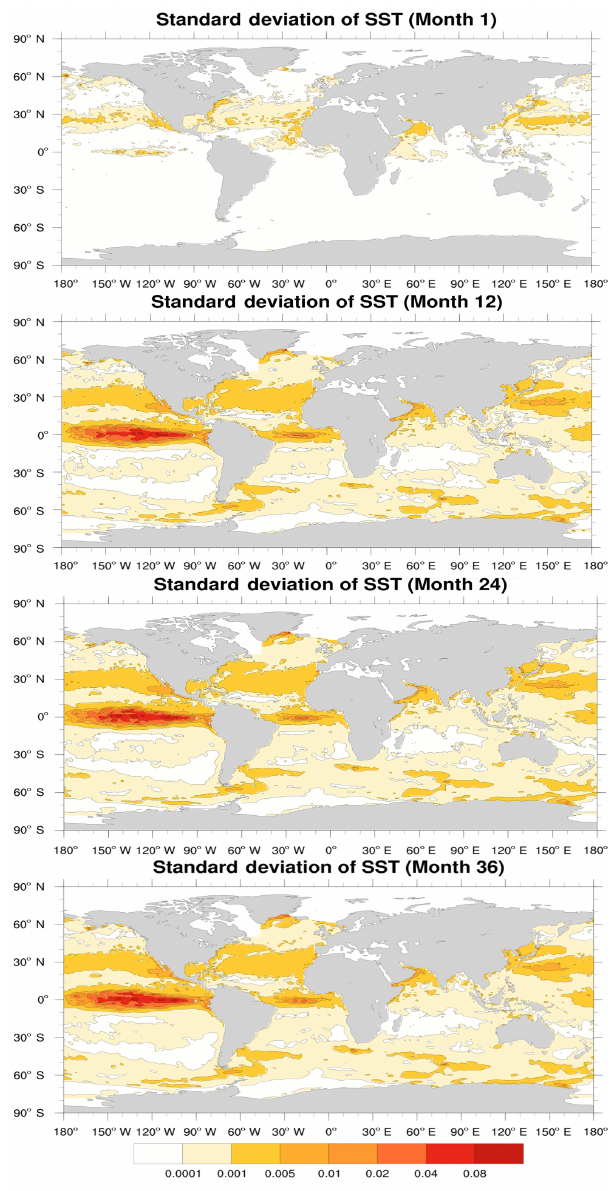
Figure 3. The ensemble distribution for the standard deviation of sea surface temperature (SST) at months 1, 12, 24, and